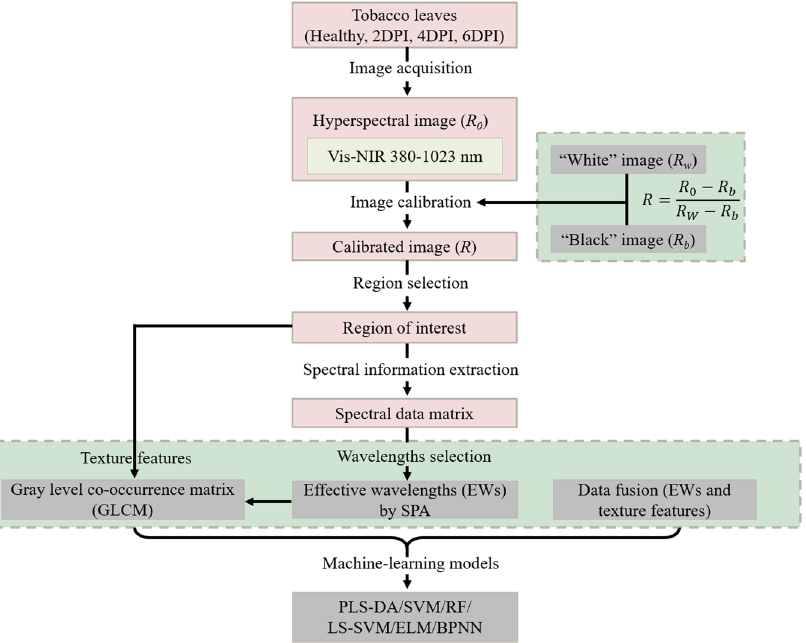
Figure 6. Flowchart of image preprocessing and data analysis for presymptomatic detection of tobacco